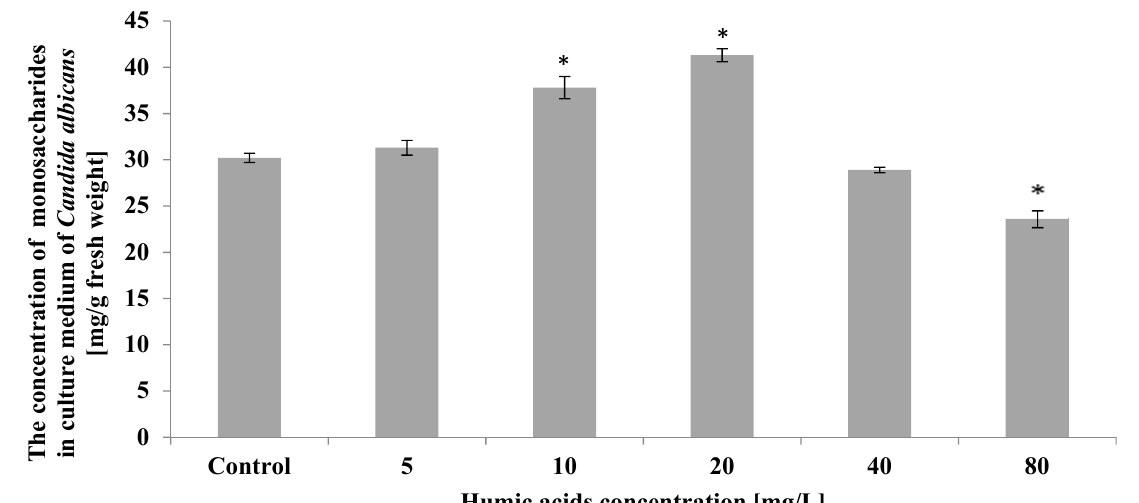
Figure 5. The effect of humic acids on monosaccharaide concentration in culture medium of Candida albicans on the 5th day of culture ( n = 8, average values ± SD, p ≤ 0.01), (*) shows statistically significantly different values in comparison with control sample.